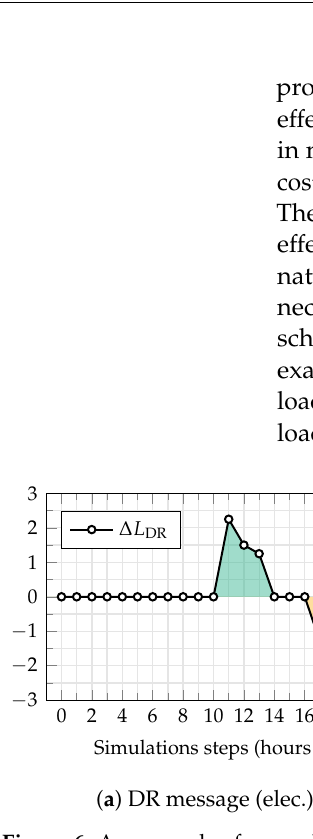
Figure 6. An example of an explicit DR event defined for electric power of multiple residential consumers (orange signifies energy to be removed wile green signifies energy to be added) and the ideal resulting aggregate